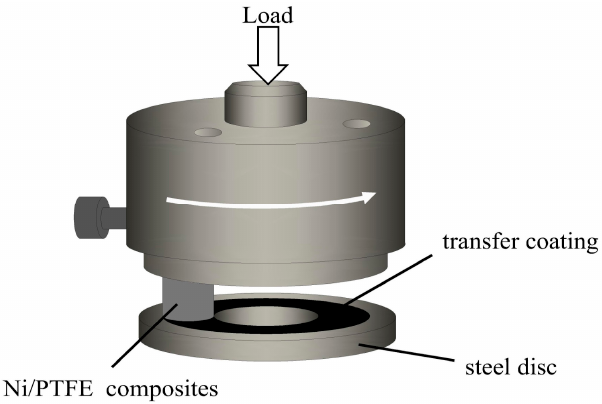
Figure 1. Schematic diagram of the pin-on-disc tribometer.